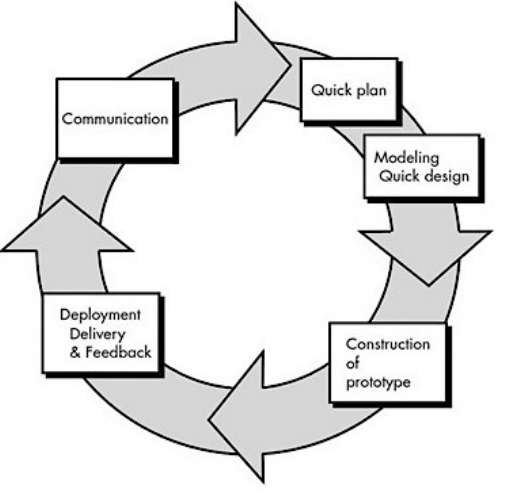
Figure 3. Prototype Model [36].